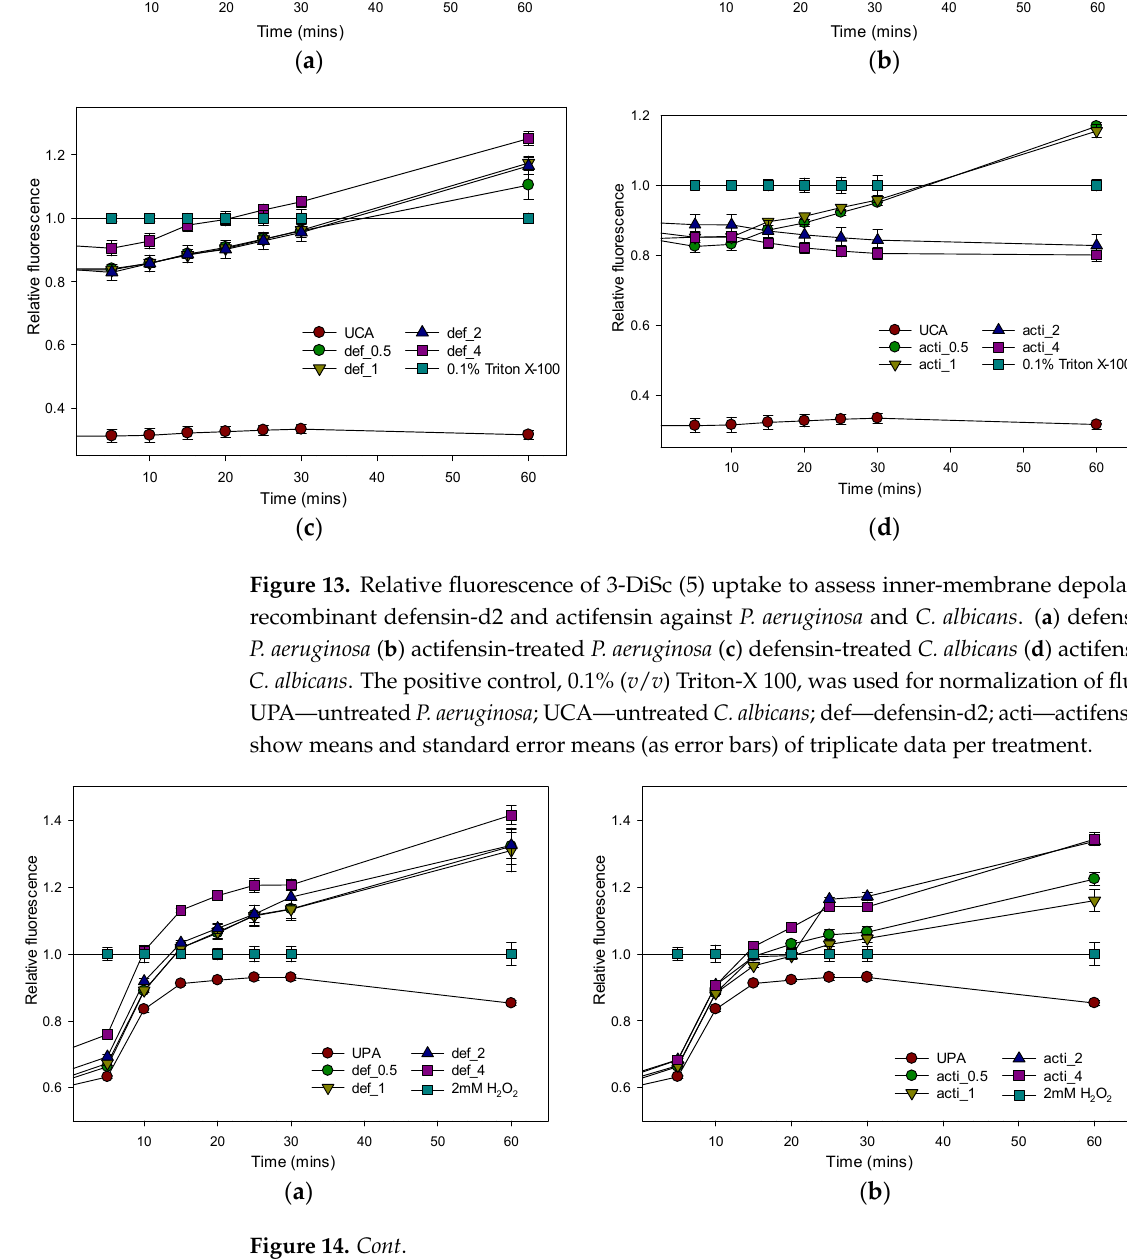
( d ) Figure 14. Relative fluorescence of H 2 DCFDA for assessing ROS production in P. aeruginosa and C. albicans treated with recombinant defensin-d2 and actifensin. ( a ) defensin-treated P. aeruginosa ( b ) actifensin-treated P. aeruginosa ( c ) defensin-treated C. albicans ( d ) actifensin-treated C. albicans . The positive control, 2mM H 2 O 2 , was used for normalization of fluorescence. UPA—untreated P. aeruginosa ; UCA—untreated C. albicans ; def—defensin-d2; acti—actifensin. Graphs show means and standard error means (as error bars) of triplicate data per treatment. 3. Discussion 3.1. Bioinformatics Analysis of the Peptides Antimicrobial peptides (AMPs), and especially defensins and defensin-like classes, hold great prospects as effective antimicrobials against MDR pathogens. Studies have shown that the presence of highly conserved cysteine residues and disulfide bonds in defensins and defensin-like AMPs provide high stability, which is a crucial feature that is needed for the efficacy of antimicrobials [17,18]. The in silico characterization of defensin- d2 and actifensin that was conducted in this study affirms previous reports on the estimated molecular weights and cysteine-rich features of the peptides [8,10]. In defensin- d2, the eight cysteine residues in the peptide sequence were predicted to form C1–C8, C2– C5, C3–C6 and C4–C7 disulfide bonds, while, in actifensin, the cysteine residues formed three disulfide bonds at C1–C4, C2–C3 and C5–C6. The disulfide connectivity patterns of both peptides, based on the pairing of the cysteine residues, indicated that they have the αβ architectural conformation [19,20]. The cysteine-stabilized αβ motif is a peculiar feature of defensins from plants, mussels, insects, and fungi [17], which thus makes actifensin derived from Actinomyces ruminicola a unique bacteriocin, with a high similarity to plant and fungal defensins, as previously reported [10].